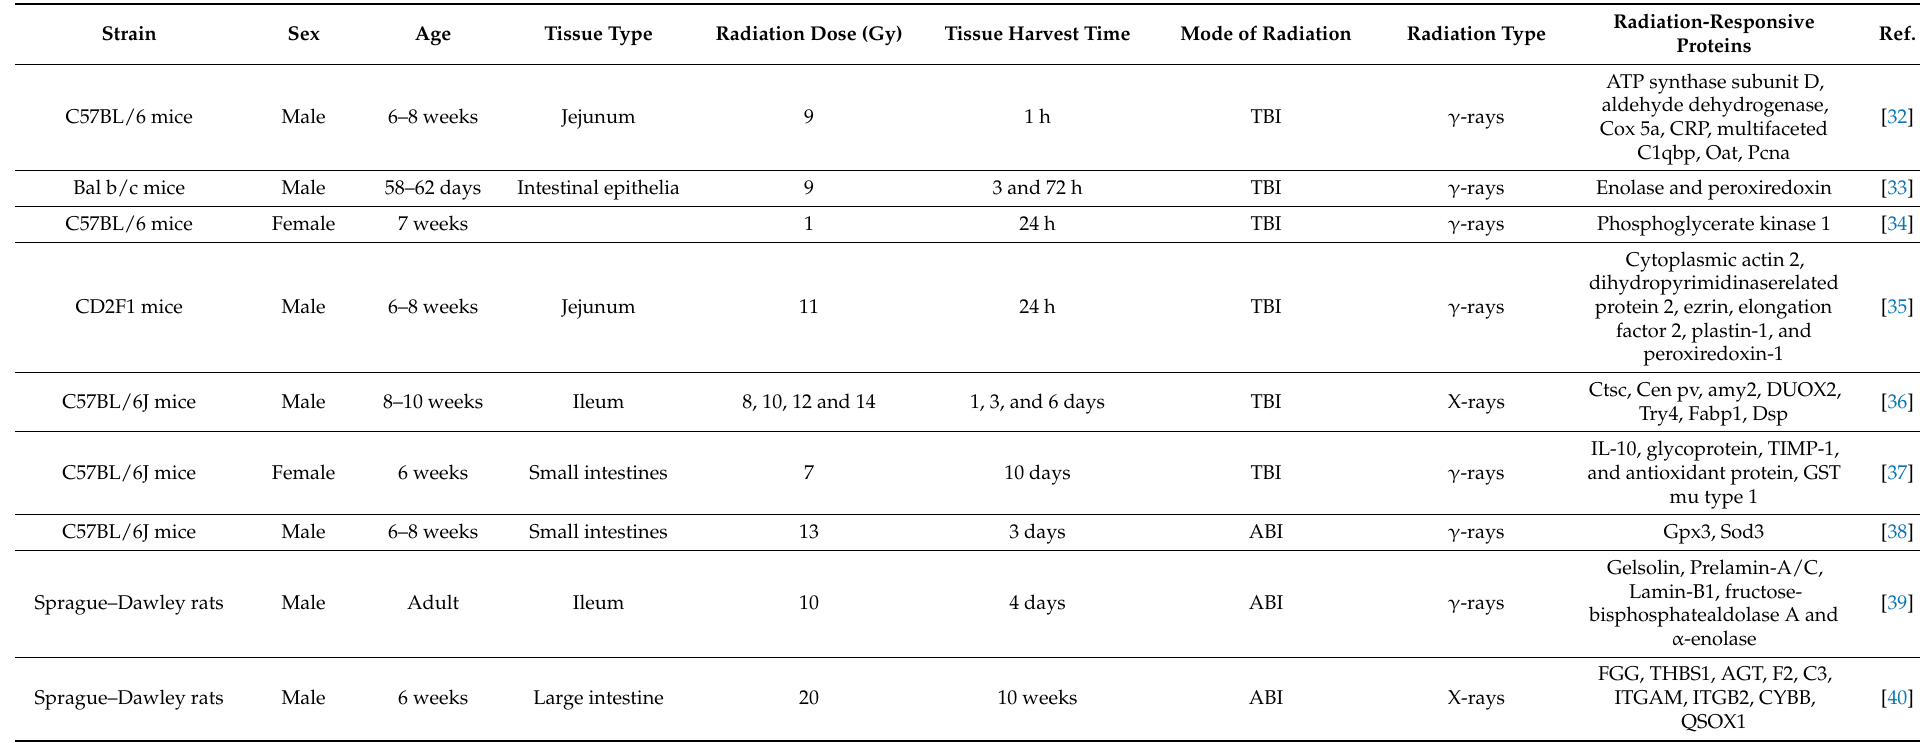
Table 1. Preclinical rodent models used for quantitative proteomics study in the intestinal tissue following radiation